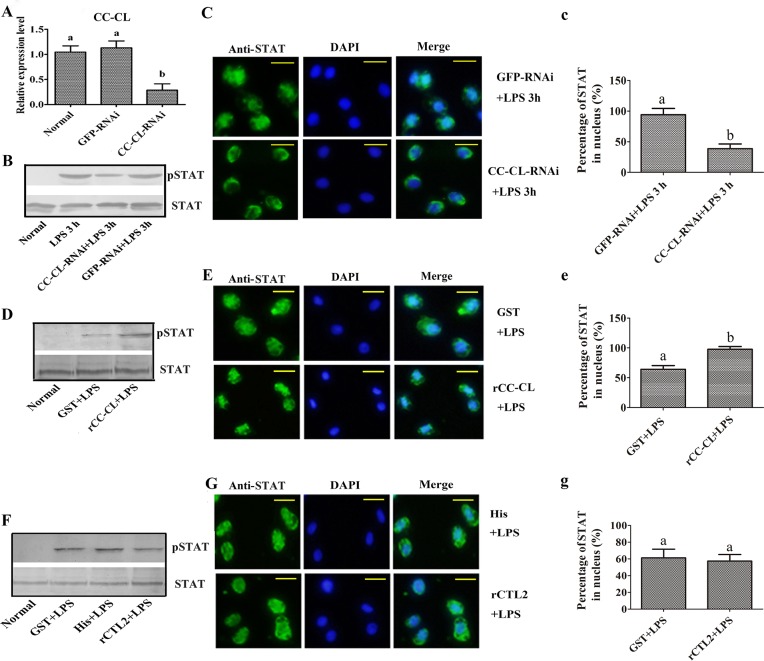
MjCC-CL mediates activation of JAK/STAT signaling.(A) The RNAi efficiency of MjCC-CL was analyzed by qRT-PCR. (B) STAT phosphorylation in MjCC-CL-silenced-shrimp was detected by western blotting. (C) STAT translocation in the hemocytes of MjCC-CL-silenced shrimp was detected with an immunocytochemical assay with a STAT-specific antibody. (c) Statistical analysis of C: the percentage of cells with translocated STAT in the nucleus was analyzed using WCIF ImageJ software. (D) STAT phosphorylation in rMjCC-CL-injected shrimp was determined by western blotting. (E) STAT translocation in the hemocytes of rMjCC-CL-injected shrimp was detected using an immunocytochemical assay with a STAT-specific antibody. (e) Statistical analysis of E: the localization of STAT within the nucleus was analyzed using WCIF ImageJ software. (F) STAT phosphorylation in rCTL2-injected shrimp was determined by western blotting (CTL2 is a C-type lectin from M. japonicus without a CCD that was used as a control). (G) STAT translocation in the hemocytes of rCTL2-injected shrimp was detected with an immunocytochemical assay with a STAT-specific antibody. (g) Statistical analysis of G: the localization of STAT within the nucleus of hemocytes was analyzed using WCIF ImageJ software. Different letters indicate significant differences (p < 0.05) in one-way ANOVA analysis.